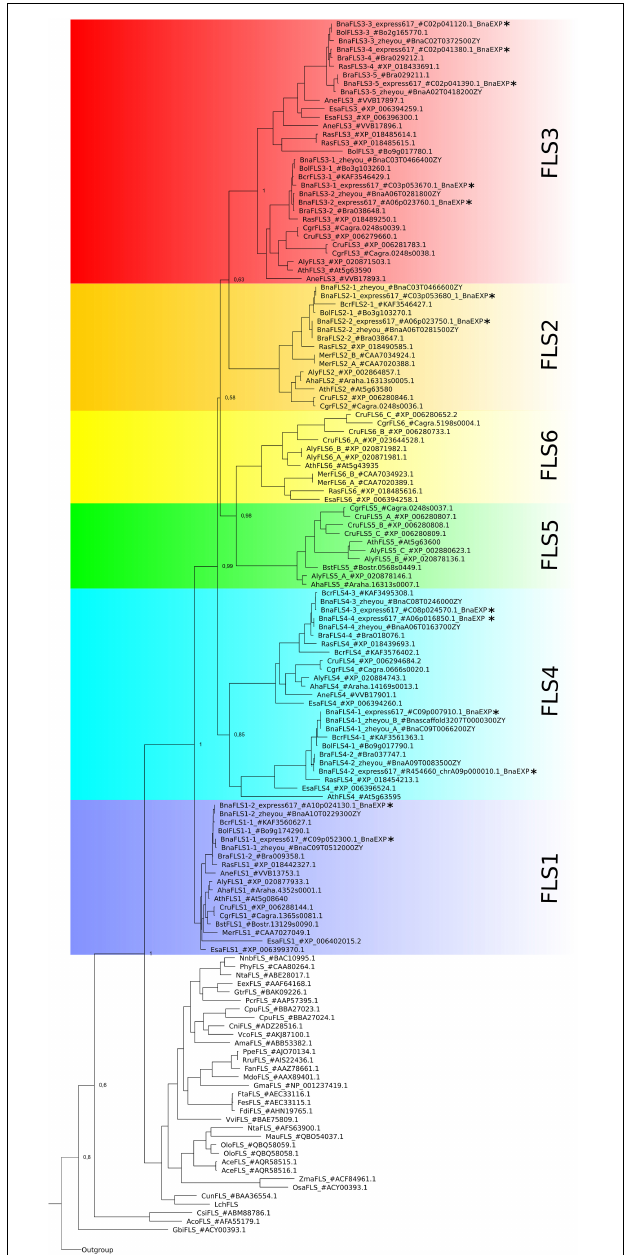
FIGURE 2 | Phylogeny of BnaFLS candidates and previously described FLS sequences. Relative bootstrap-values are shown next to relevant nodes. The phylogenetic tree is based on amino acid sequences. FLS family members of B. napus Express 617 are marked with an asterisk. The outgroup comprises the 2-ODD members ANS and F3H, as well as 2-ODD-like sequences ( Supplementary Figure 1